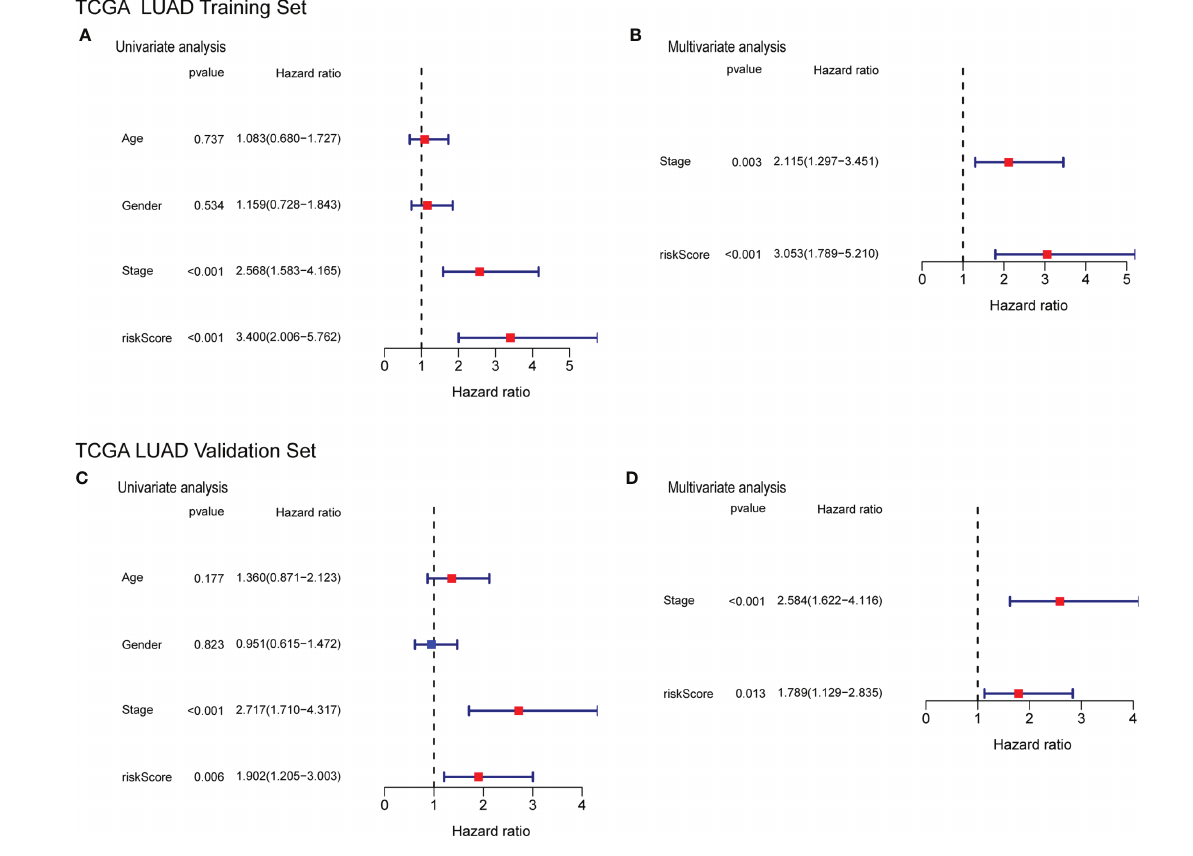
FIGURE 9 | Forrest plot of the univariate and multivariate Cox regression analyses regarding OS in the TCGA training cohort (A, B) and the TCGA validation cohort (C, D)